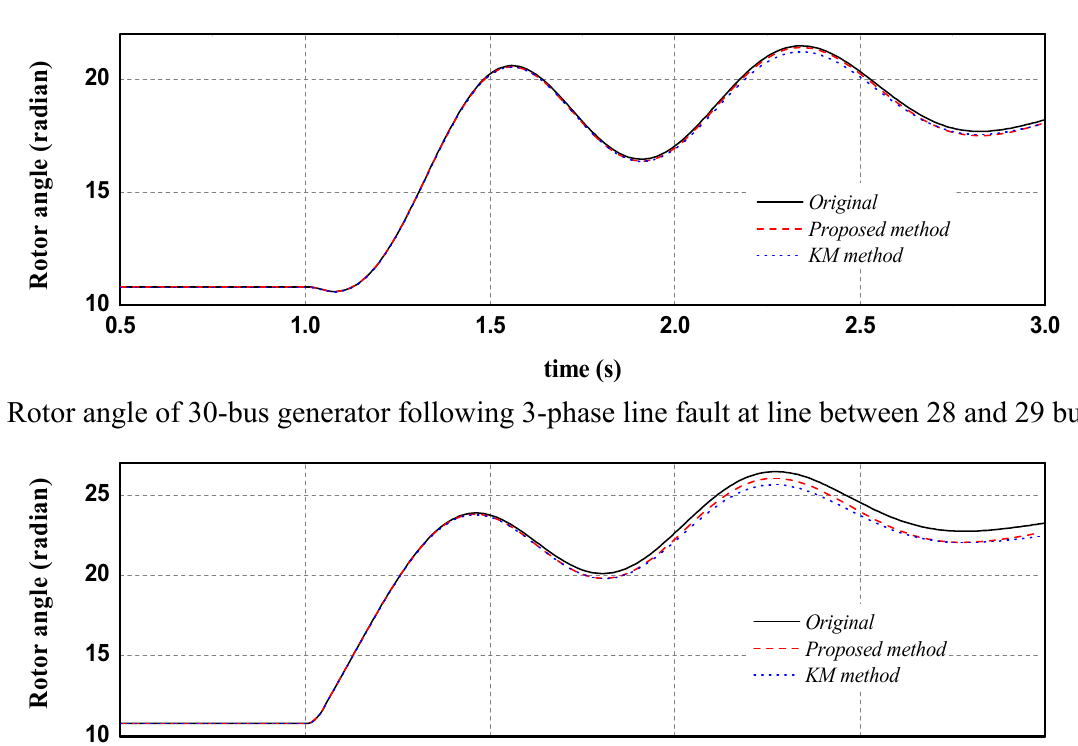
Figure 5. Rotor angle of a 30-bus generator following each